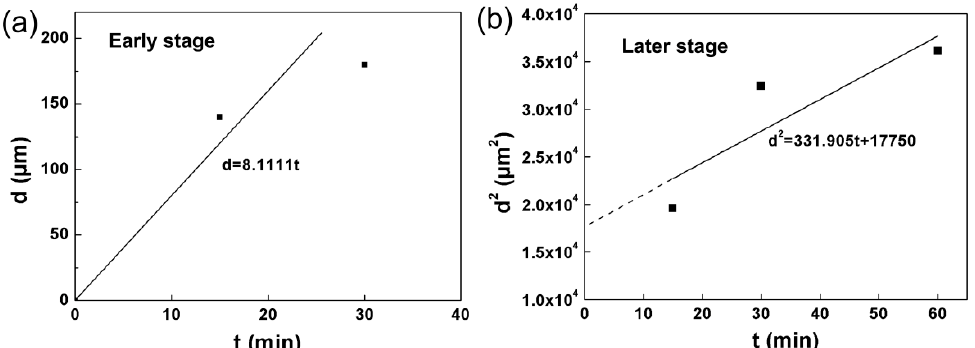
Figure 8. The fitness of 𝑑 (cid:3041) = K𝑡 for the changes of Cr-diffusion coating thickness d as a function of chromizing time t : ( a ) interface reaction controlled growth; ( b ) atom diffusion controlled